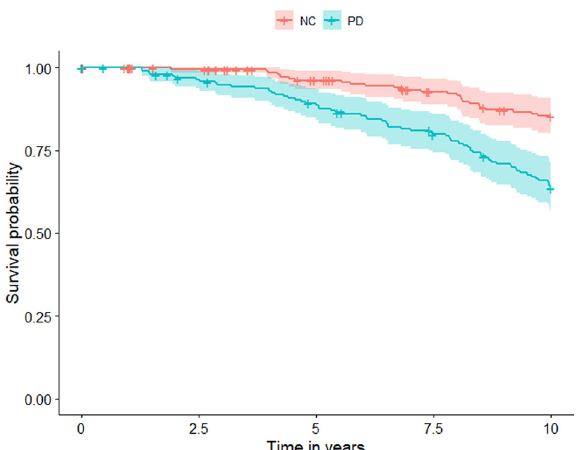
Fig. 1 10-year survival in newly diagnosed Parkinson ’ s disease (PD) patients and normal controls (NC). Ten year survival curves of PD and NC are displayed here. The shaded area represents the con fi dence intervals.